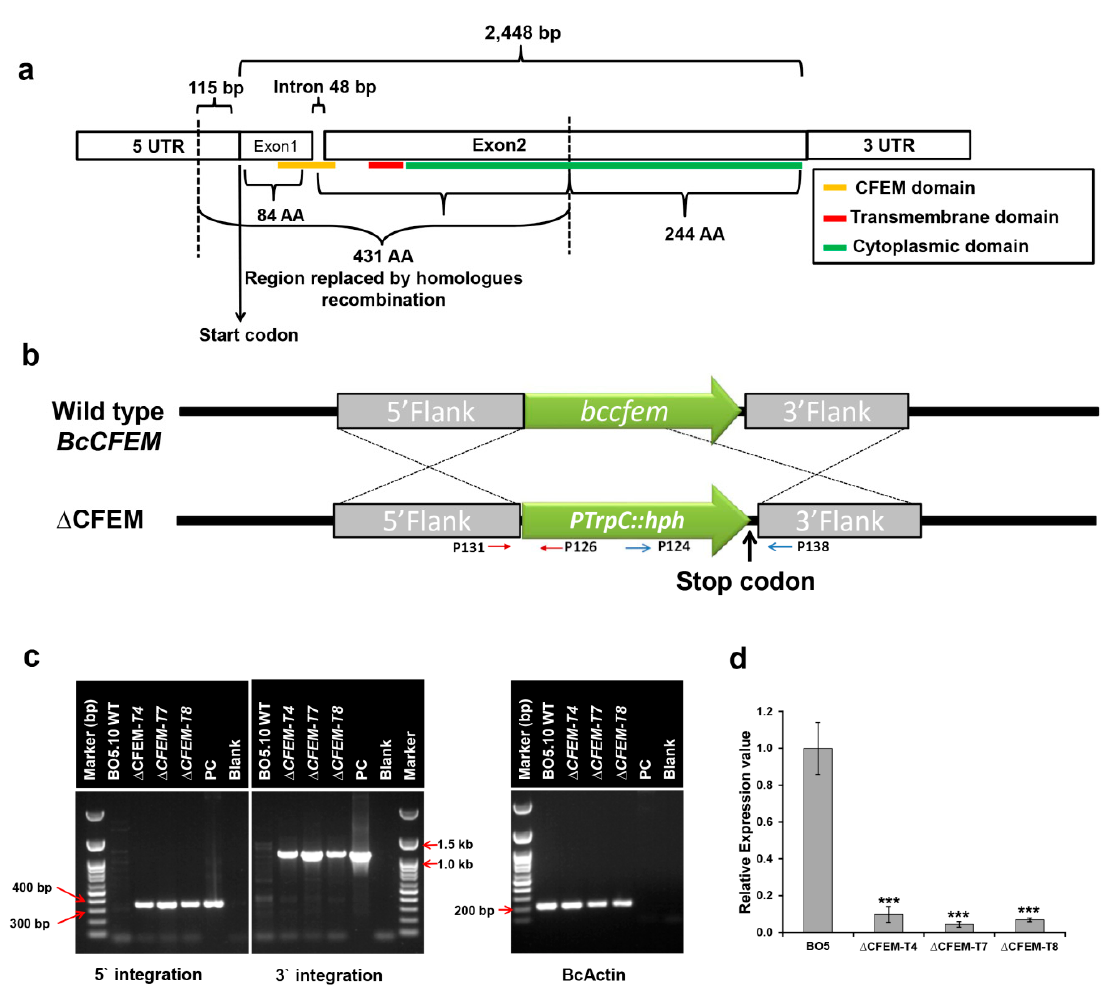
Figure 1. Identification and deletion of the CFEM- Bcin07g03260 gene in WT B. cinerea. ( a ) Genomic arrangement of the CFEM- Bcin07g03260 gene in the B. cinerea genome showing the CFEM domain (yellow), transmembrane domain (red), cytoplasmic domain (green) and the region that was replaced by homologous recombination (1456 bp). ( b ) Homologous recombination-based construct used for deletion of the Bcin07g03260 gene. The 5’ and 3’ flanks were amplified (with restriction sites) from genomic DNA and cloned in either side of the Hyg cassette, which was used to transform WT B. cinerea protoplasts. Red, and blue arrows indicate primers used for 5' and 3' integration, respectively. ( c ) Diagnostic PCR showing the successful integration of the Hyg cassette (PtrpC:hph) in the B. cinerea genome. The primers used to confirm the integration (Table 2) are indicated in panel B (5' integration – red arrow, and 3' integration – blue arrow; PC-Plasmid control for PCR). ( d ) Real-time qPCR showing negligible expression of the CFEM- Bcin07g03260 gene transcript in the deletion mutants. The transcript level was determined using gene specific primers (Table 2). The expression was normalized using expression of B. cinerea UCE. The expression analysis was performed on three biological replicates, each containing three technical repeats. Bars indicate standard error (SE) (*** indicate p < 0.001, obtained by Student’s T-test).